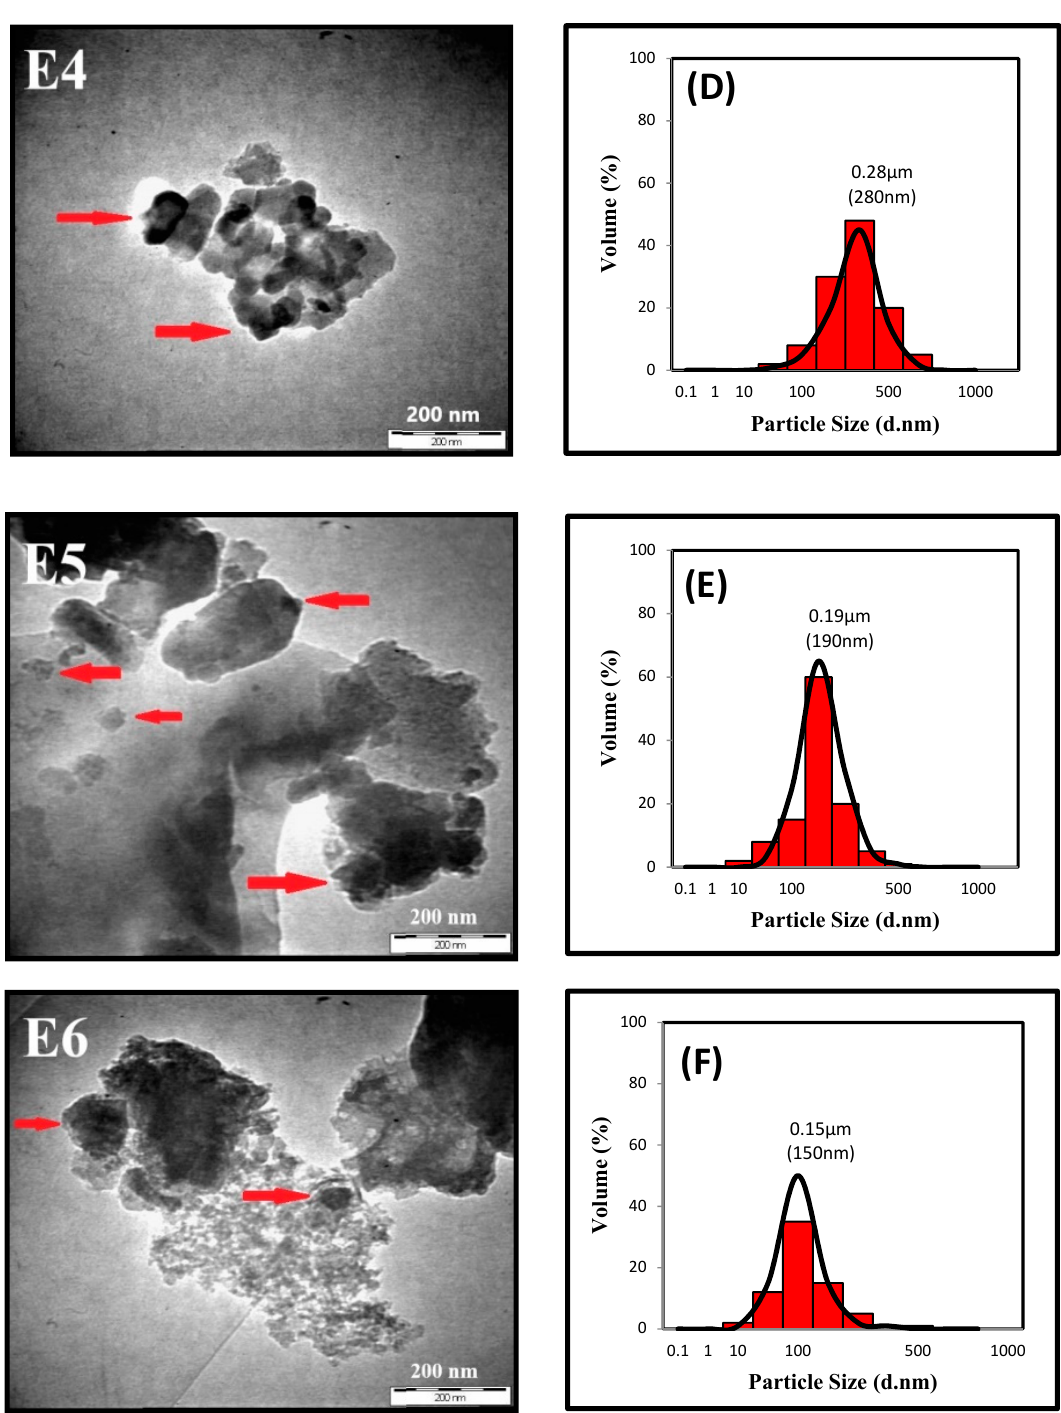
Figure 4. TEM image (E4–E6) and POA nanoparticle distribution ( D – F ) from the experiment four, five, and six of the Taguchi optimization processes.